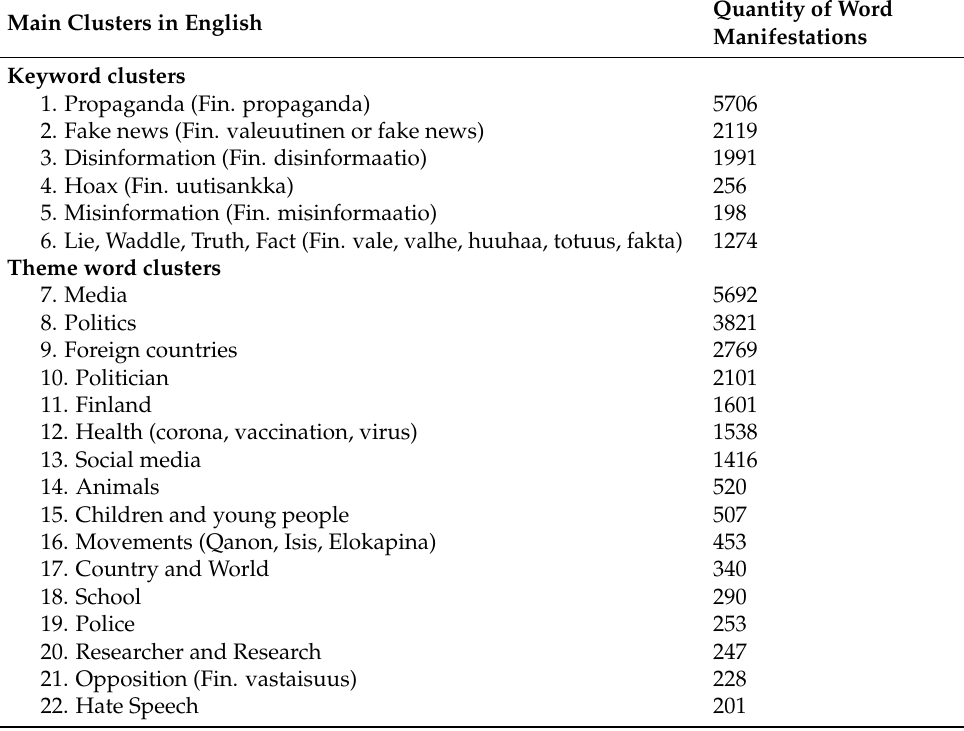
Table 6. Result of word count analysis.